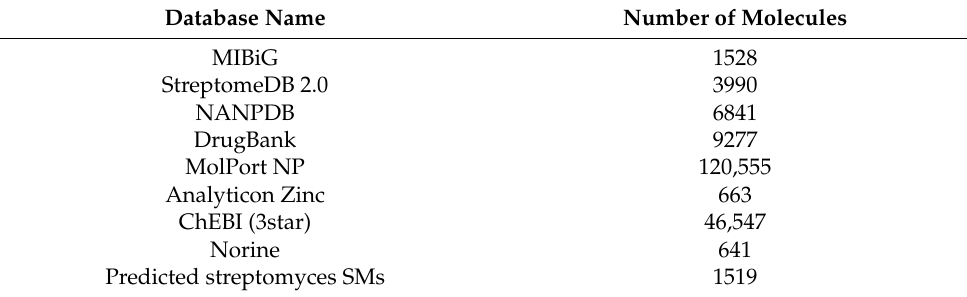
Table 14. Databases and the number of stored molecules used for the screening of predicted scaffolds. All compounds are linked to their source database. The predicted streptomyces SMs are linked to the preprocessed database on the SeMPI v2 web